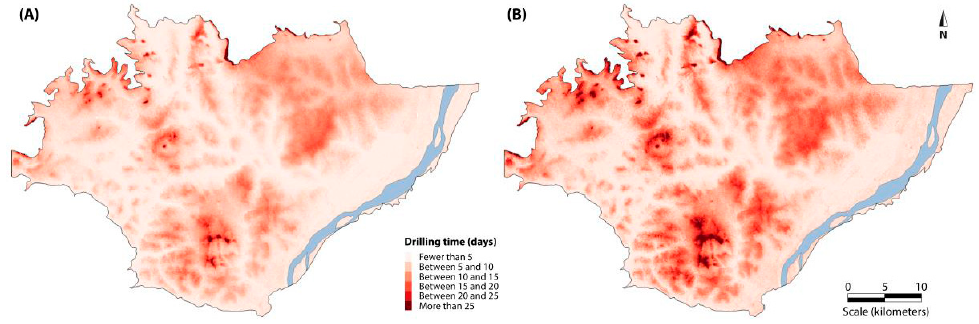
Figure 12. Approximate drilling time maps for ( A ) two-inch diameter boreholes, and ( B ) four-inch diameter boreholes. Water 2017 , 9 , 262